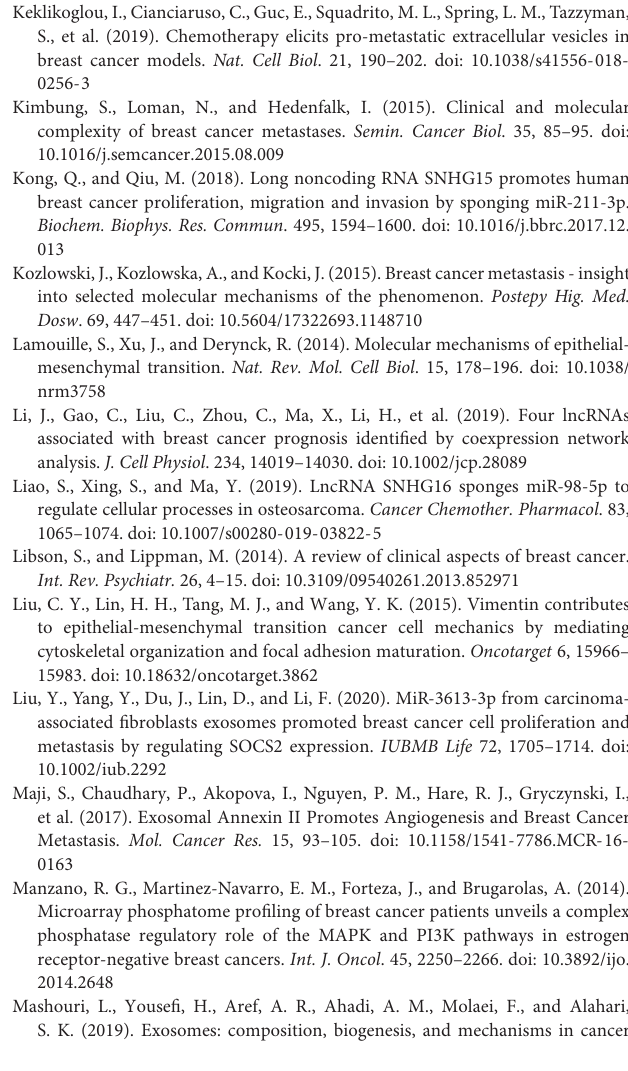
Supplementary Figure 1 | Prediction of the co-expression of miR-892b with SNHG16 or PPAPDC1A. (A) ENCORI pancancer database was used to predict the correlation between miR-892b and SNHG16 expression in BC patients. (B) ENCORI pancancer database was used to predict the correlation between miR-892b and PPAPDC1A (PLPP4) expression in BC